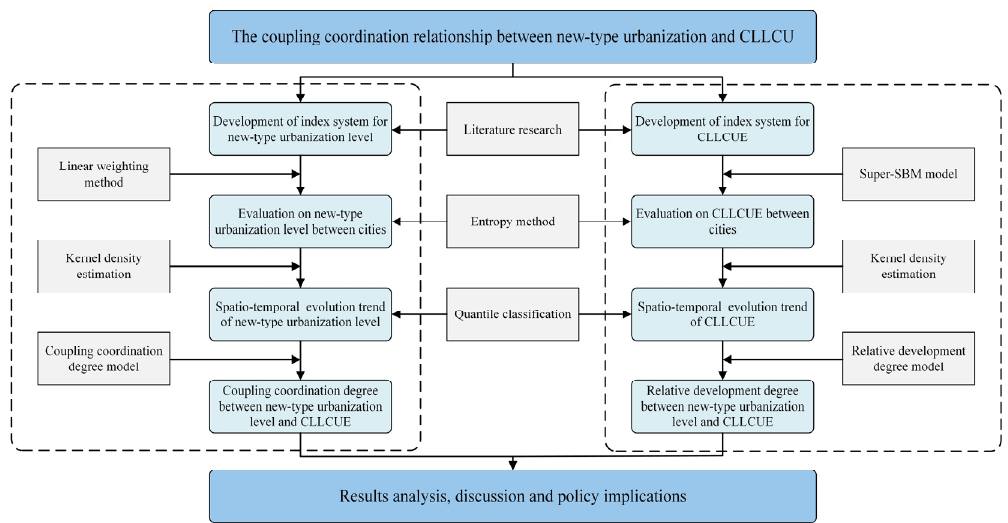
Figure 3. Evaluation framework of coupling coordination relationship between new-type urbaniza- tion and CLLCU.